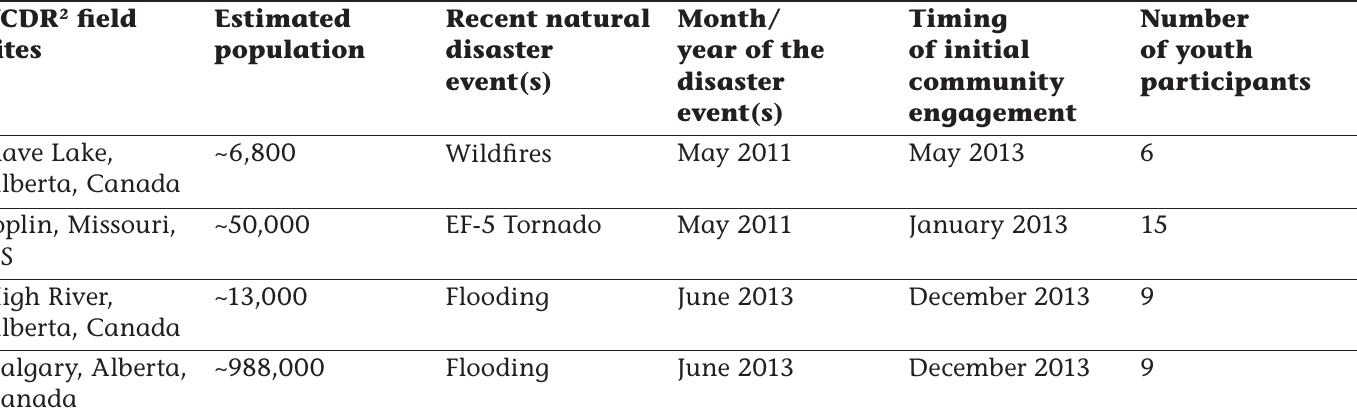
Table 1: YCDR 2 Field sites and workshop